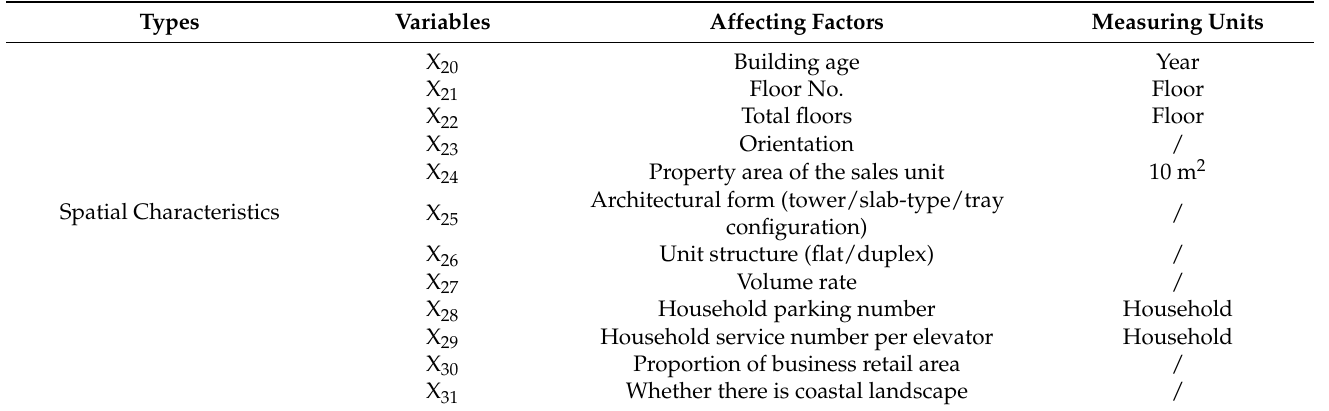
Table 3. Factors affecting residential spatial